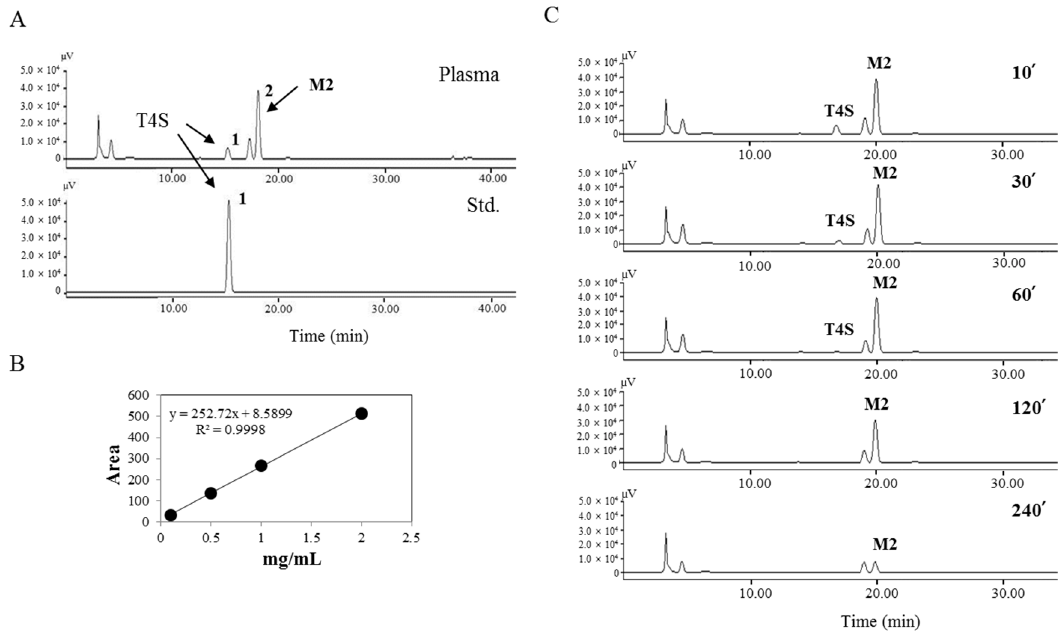
Figure 2. HPLC chromatogram of tyrosol metabolites in rat plasma. ( A ) Analysis of tyrosol metabolites in rat plasma following oral administration of tyrosol and standard of tyrosol-4-sulfate (T4S) using HPLC; ( B ) Standard curve of T4S; ( C ) HPLC chromatograms of tyrosol metabolites in plasma obtained at different time points following oral administration of tyrosol obtained by measuring absorbance at 280 nm.